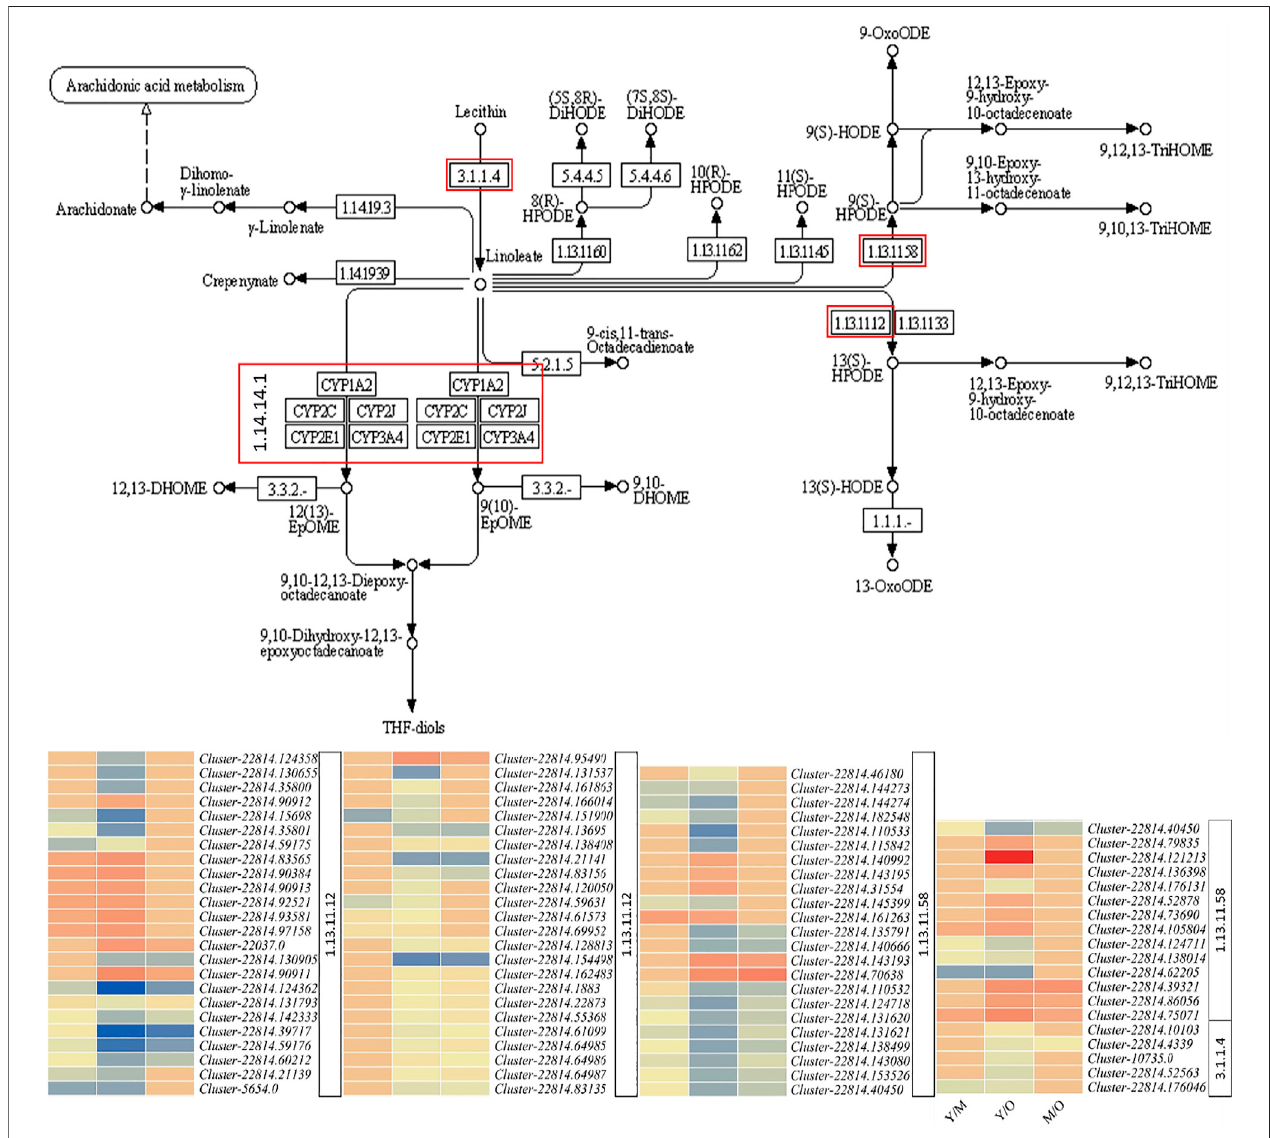
FIGURE 5 | Differential regulation of linoleic acid metabolism pathway in young (Y) mature (M), and old (O) ginger rhizome. The red boxed genes/enzymes were differentiallyexpressedbetweendifferenttissues.Theheatmapsrepresentthelog2foldchangevaluesofthedifferentiallyexpressedgenes.Thenumberswithheatmaps represent corresponding red boxes in the pathway fi gure panel i.e., EC: 1.13.11.12 (linoleate 13S-lipoxygenase 2-1, chloroplastic/lipoxygenase), E.C: 1.13.11.58 (linoleate 9S-lipoxygenase), E.C: 1.14.14.1 (cytochrome P450 71A1-like), and E.C: 3.1.1.4 (phospholipase A2-alpha/phospholipase A2 homolog 3-like).